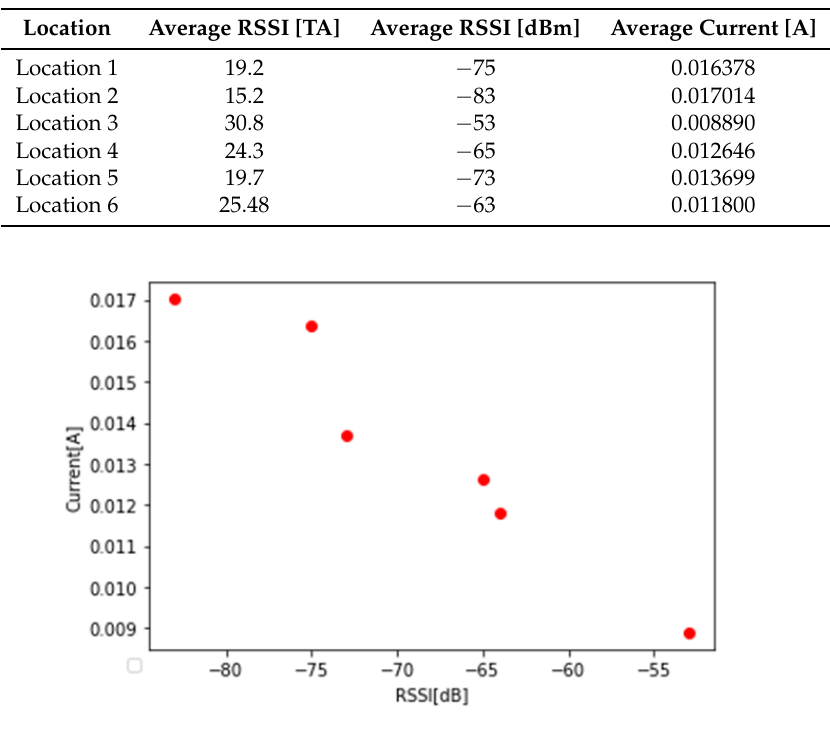
Figure 19. RSSI vs. current